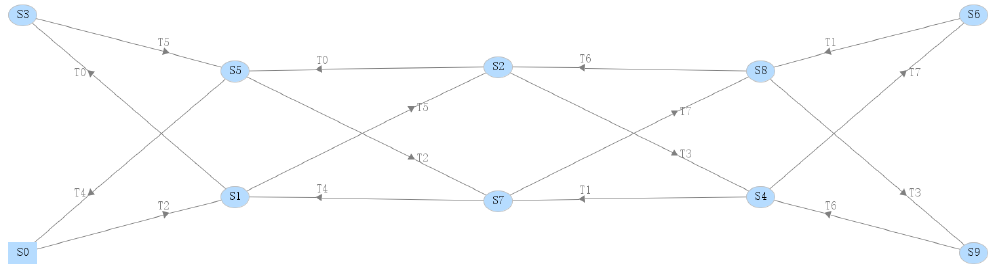
Figure 5. Reachable marking graph of improved Petri net of ACC.